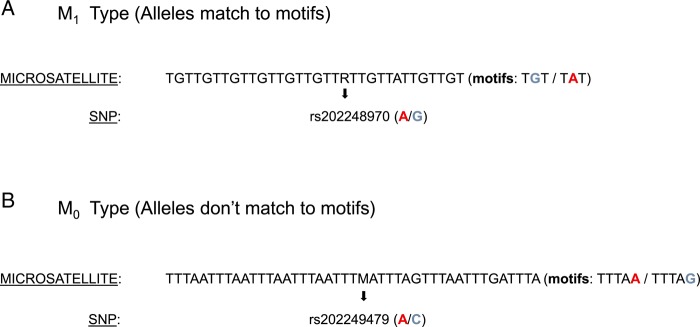
Imperfect microsatellites with M1 and M0 SNP alleles. (A) The M1 type: these are microsatellites where the SNP alleles match with the variant nucleotide of the motif sequences. The SNP ID is shown by rs # and the alleles are shown within parenthesis. The microsatellite and the mismatch motifs are shown, and both A and G are represented in the motifs. (B) The M0 type: these are microsatellites where the alternative SNP alleles are not found in the motif sequences of the microsatellite. Note that the C allele of the SNP is not represented in the mismatch motif.